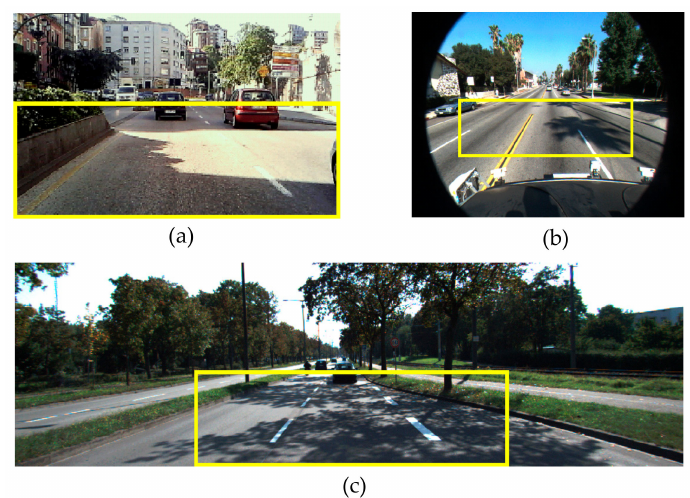
Figure 8. Bounding box containing the ROI in the incoming color images. ( a ) For our 240 × 320 camera, the ROI covers 110 × 320 pixels. ( b ) For the Caltech Lane dataset containing 480 × 640 images, the ROI considered covers 130 × 410 pixels. ( c ) For the Kitti dataset containing 375 × 1242 images, the ROI considered covers 170 × 574 pixels.